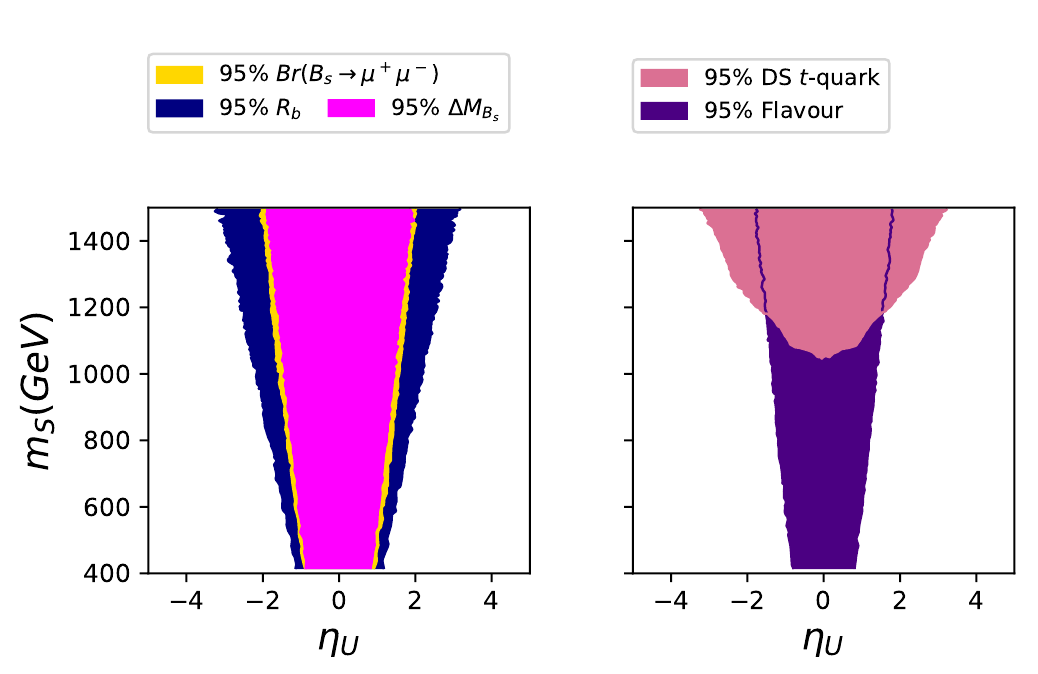
Figure 4 . Experimental constraints on the m S - η U plane. Left panel: allowed regions at 95% probability obtained from R b (blue), Br ( B s → µ + µ − ) (yellow) and ∆ M B combined flavour constraints, compared with the limits from direct searches including top quarks, at 95% probability.